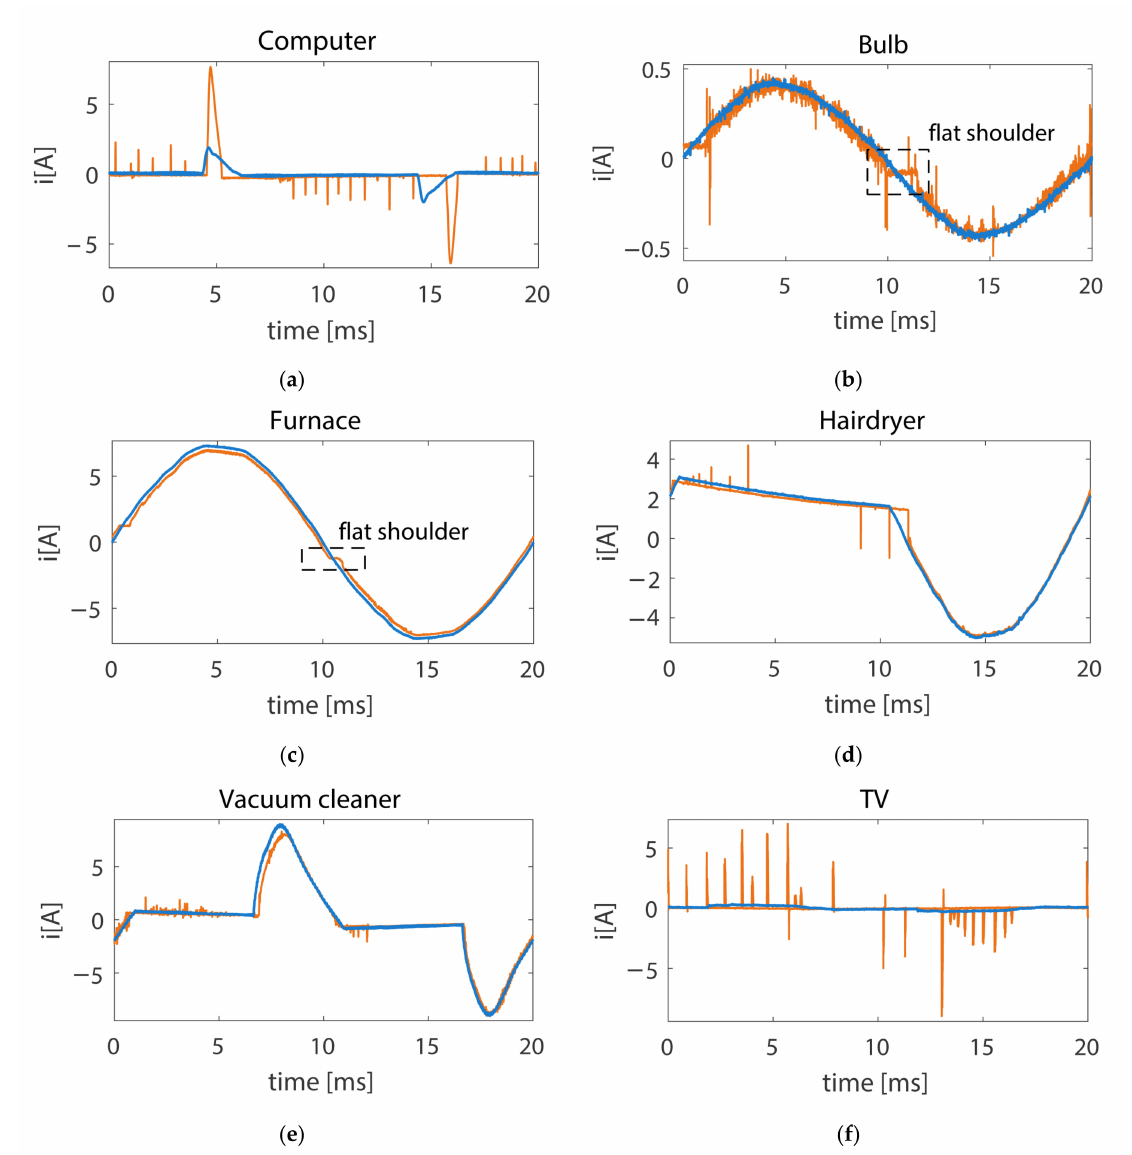
Figure 5. Current waveform for individually operating appliances with (orange line) or without (blue line) presence of series arc fault. ( a ) computer, ( b ) bulb with marked flat shoulder effect, ( c ) furnace with marked flat shoulder effect, ( d ) hairdryer, ( e ) vacuum cleaner, ( f )